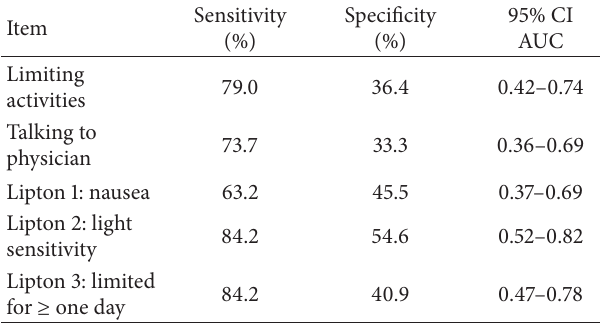
Table 5: Sensitivity and specificity of the 3-Item ID Migraine Screener in patients with and without